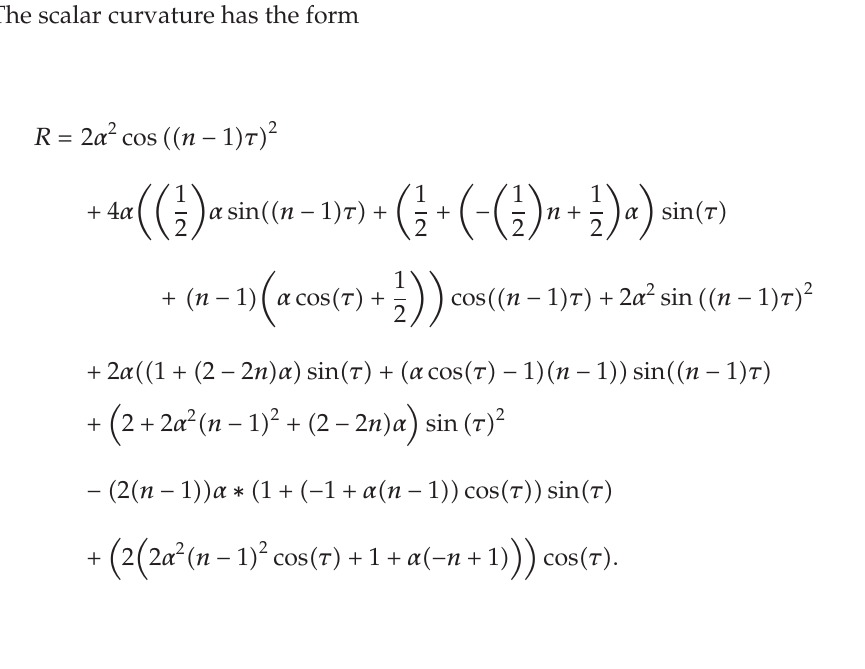
The scalar curvature has the